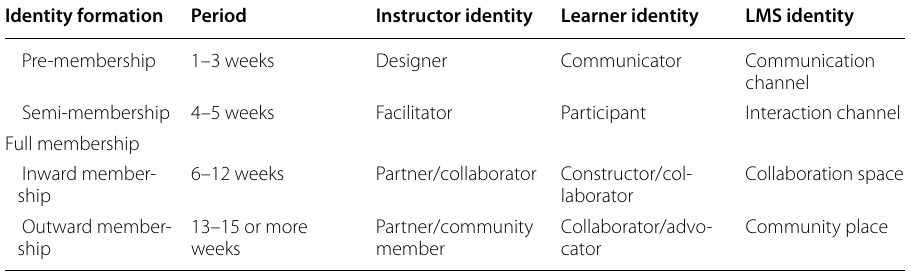
Table 1 The identity changes of online learning and teaching Identity